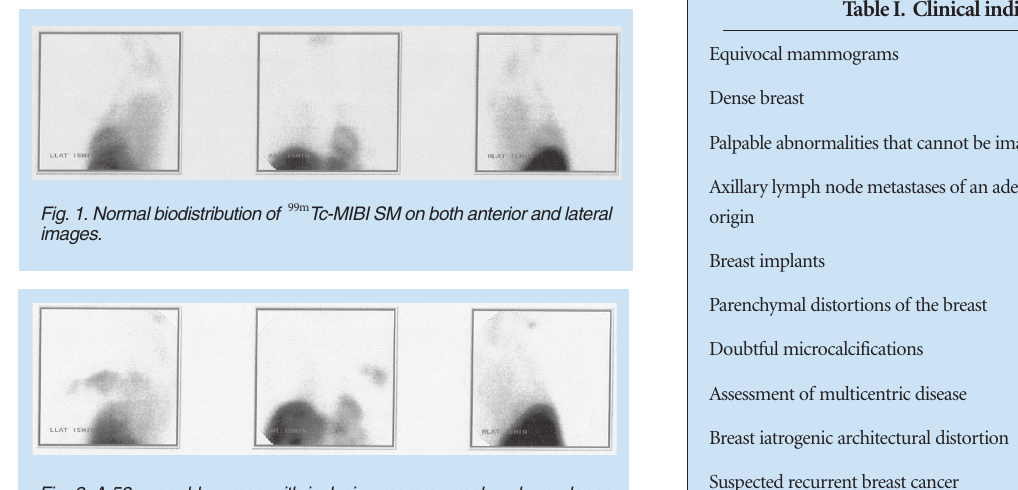
Fig. 2. A 52-year-old woman with inclusive mammography where planar anterior and left lateral SM clearly shows carcinoma with two adjacent sites of abnormal accumulation in the left breast.